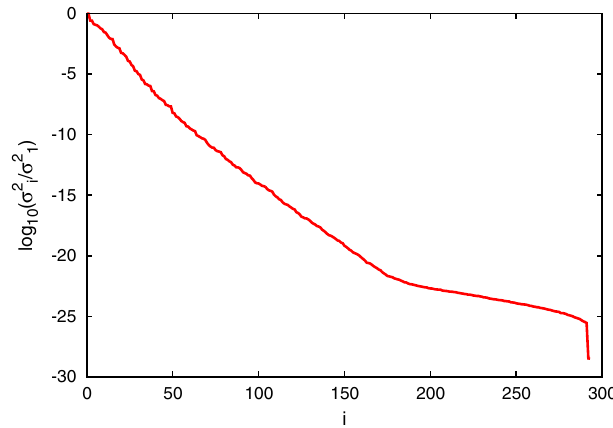
FIG. 5. (Color) Squared singular values of R The plotted value is proportional to the emittance change cor- responding to a certain BPM pattern. Only 294 BPM patterns yield a nonzero value. All other patterns belong to the null space of R cB 0